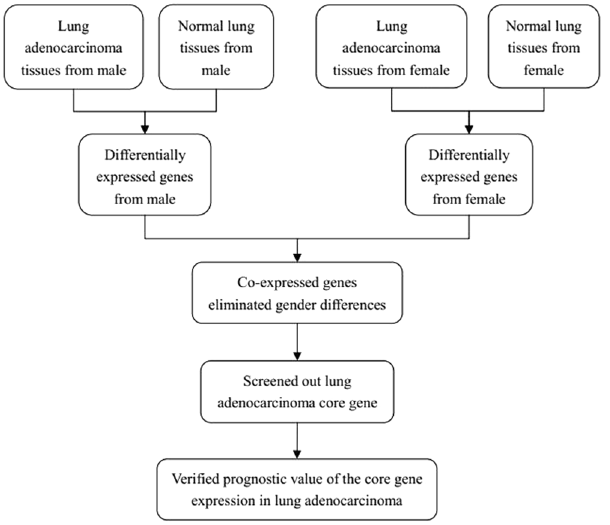
Figure 1. Flow diagram of the study